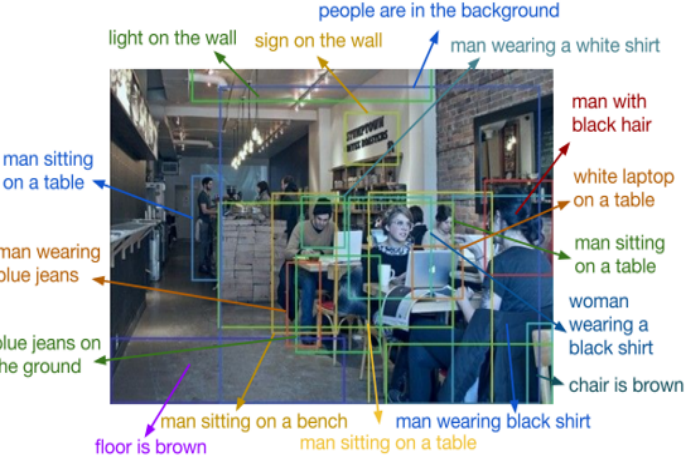
Figure 7. Image Description presented using Trained Model [61].